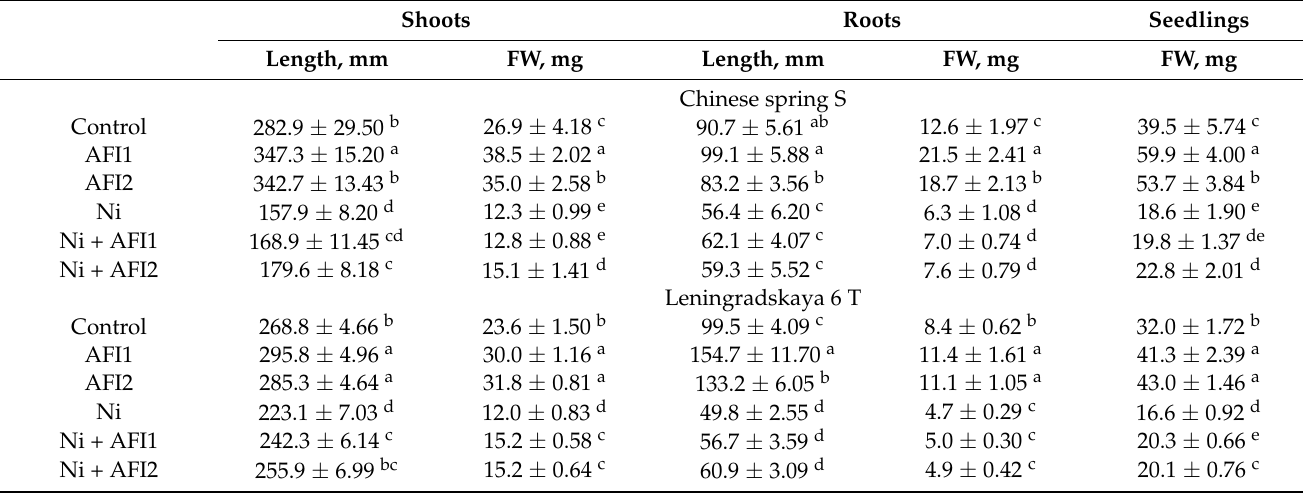
Table 2. Effect of toxic Ni concentration and inoculation with PGPB on wheat length and fresh weight (FW). Shoots Roots Seedlings Length, mm FW, mg Length, mm FW, mg Chinese spring